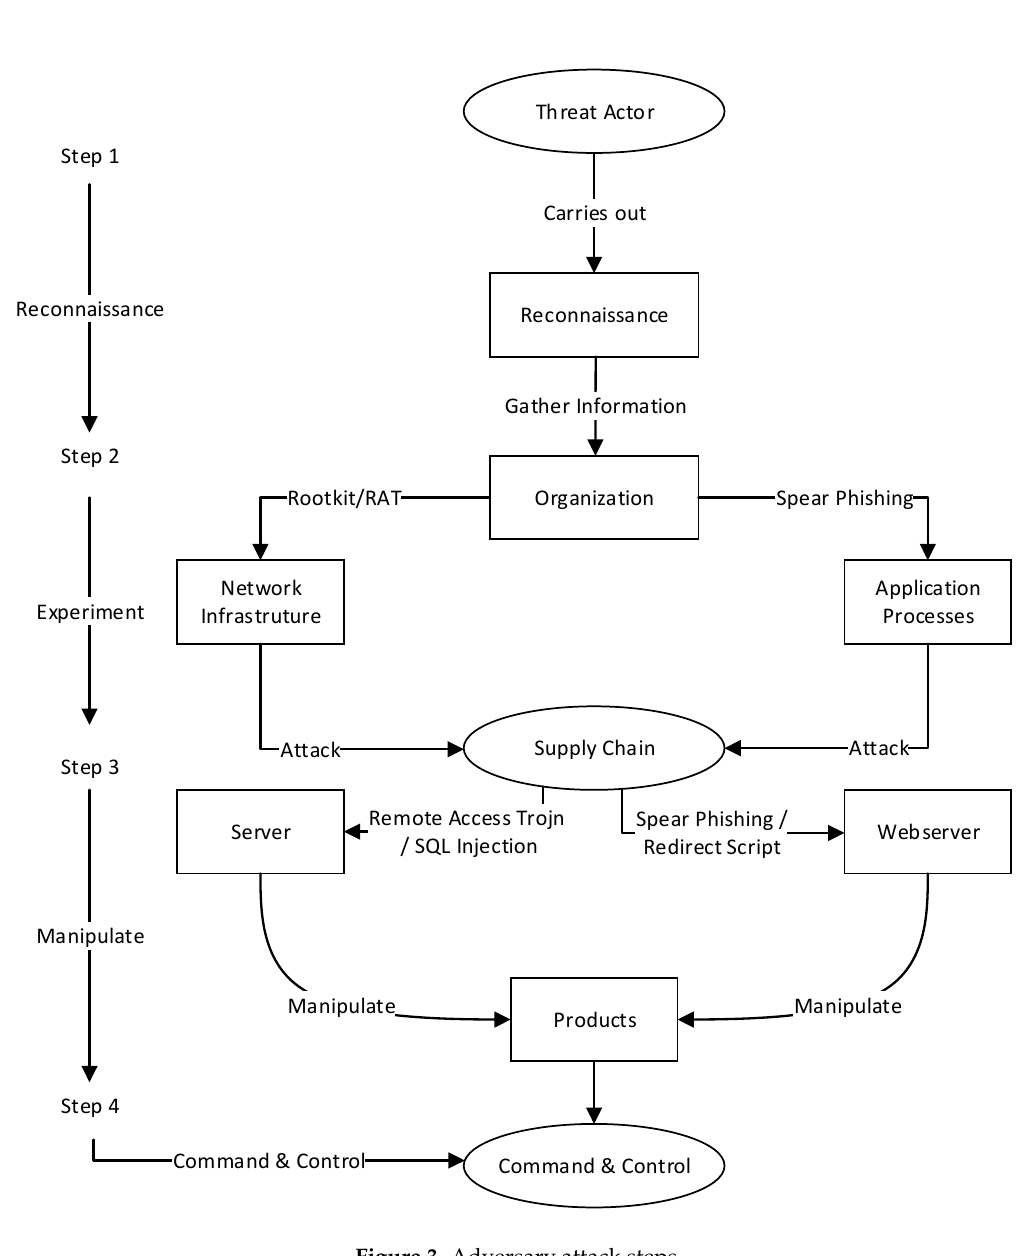
Figure 3. Adversary attack